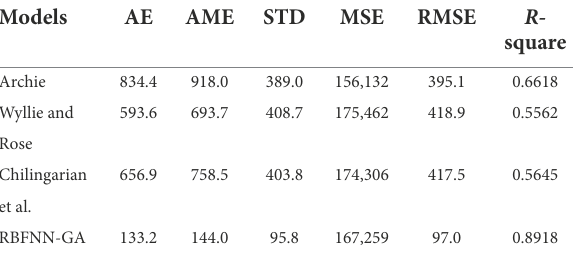
TABLE 2 Determining the static error parameters for predicting k for the testing